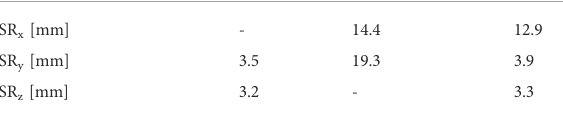
TABLE 2 Summary of the achieved spatial resolution values [FWHM] along the x, y and z-dimension in PET-only, Compton-only and γ - PET imaging